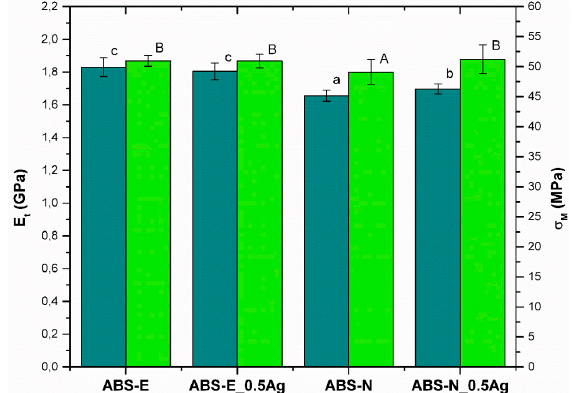
Figure 4. Young’s modulus (E t ) and tensile strength ( σ M ) of pure polymers and polymers containing silver nanoparticles. Statistically significant differences ( p < 0.05) between the tested materials are marked a-c for E t and A-B for σ M , respectively.